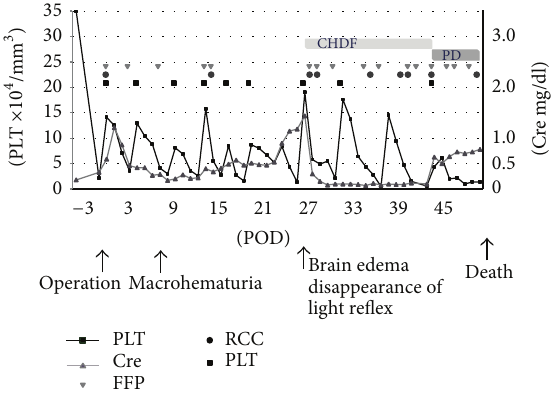
Figure 1: Laboratory findings during the clinical course.